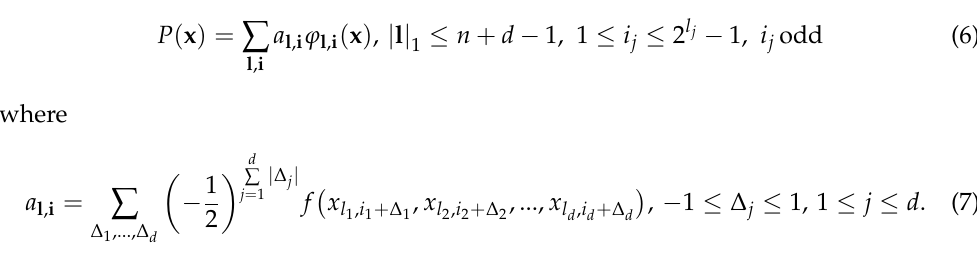
Figure 6. Examples showing interpolation using functions of two variables. ( a ) Linear combination of univariate func- tions. ( b ) Linear combination of univariate functions and a function of two variables x and y with a small coefficient. ( c ) Linear combination of univariate and a function of two variables x and y .